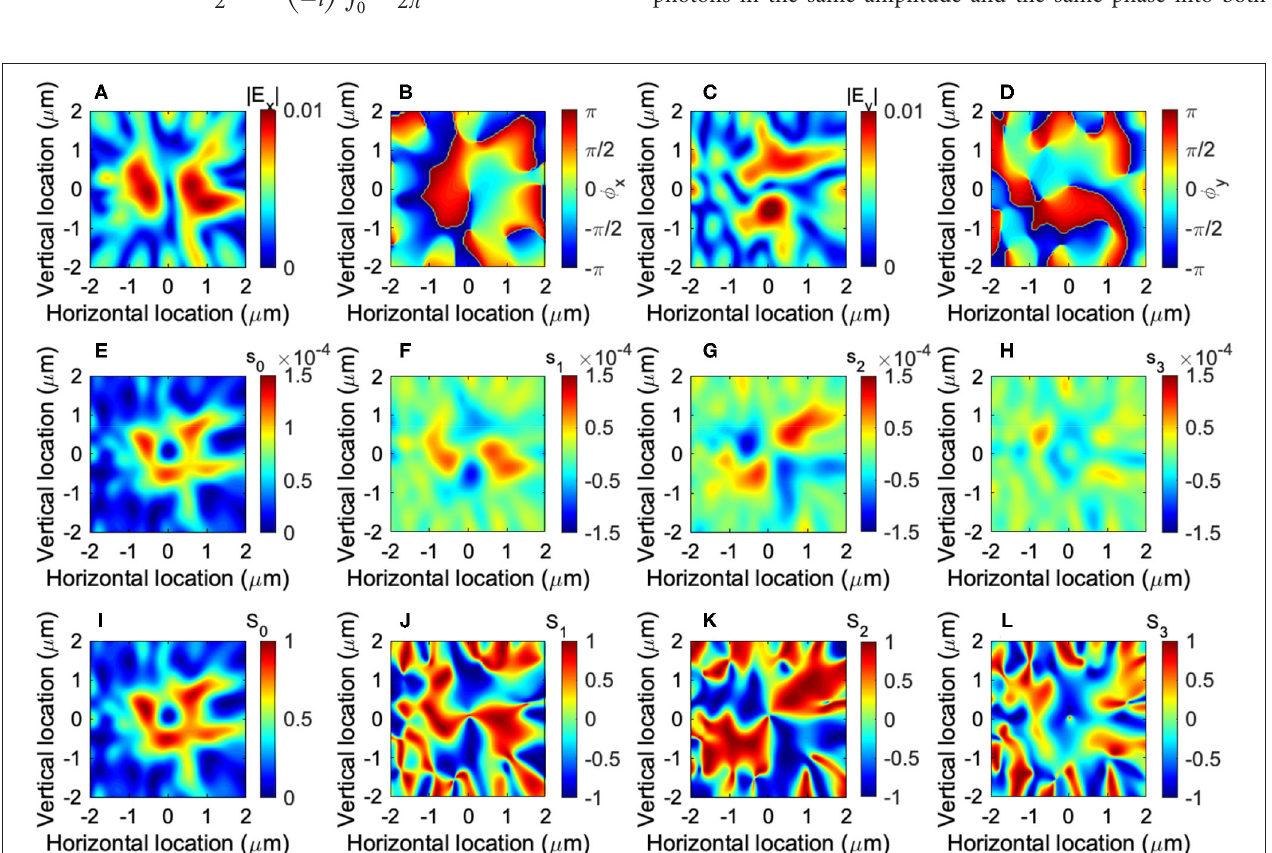
FIGURE 11 | Horizontal vortex generated from the gear of N 10. The input port 1 and 2 are used to inject photons to the waveguide, and two injected modes are in = the same phase. The mode profile of a vortex is obtained at z 1 µ m above the gear. (A) Real part and (B) imaginary part of the horizontal complex electric field ( E x ). = (C) Real part and (D) imaginary part of the vertical complex electric field ( E y ). A horizontal dipole is recognized for E x with a node at the center. (E–H) The local spin components (s 0 , s 1 ,s 2 ,s 3 ), and (I–L) normalised Stokes parameters (S 0 , S 1 ,S 2 ,S 3 ) are also shown. The circularly polarized component of s 3 (H) was substantially reduced.